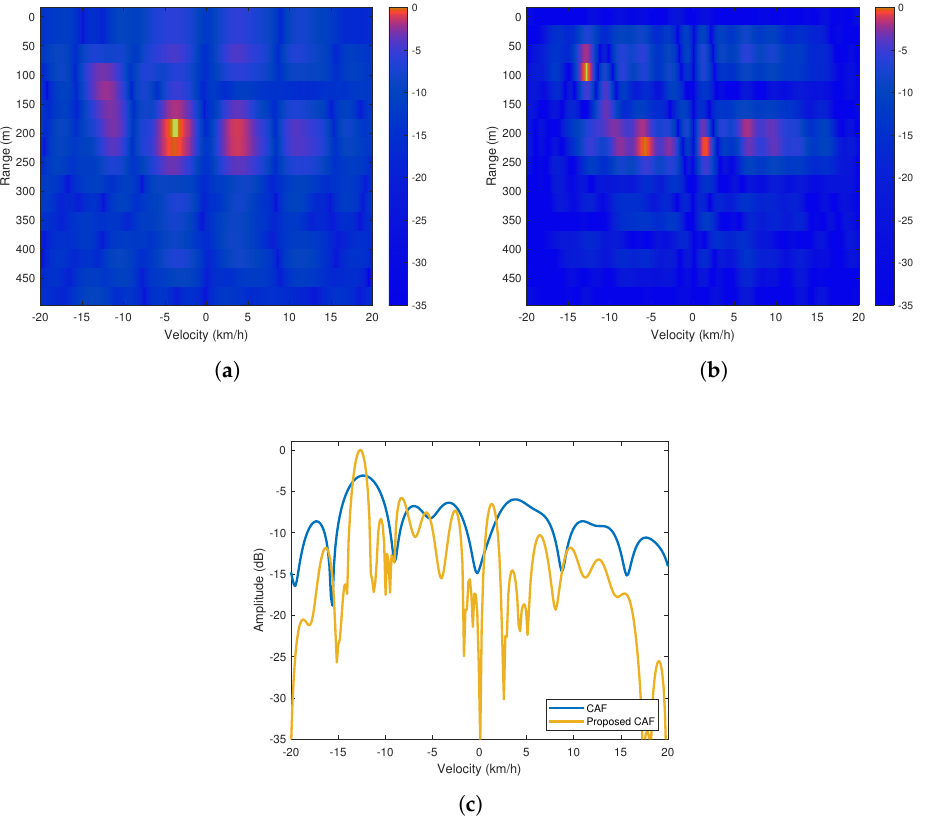
Figure 12. ( a ) Cross Ambiguity Function (CAF) range-Doppler map ( b ) Proposed method’s range-Doppler map ( c ) Doppler profiles of the maps at 75